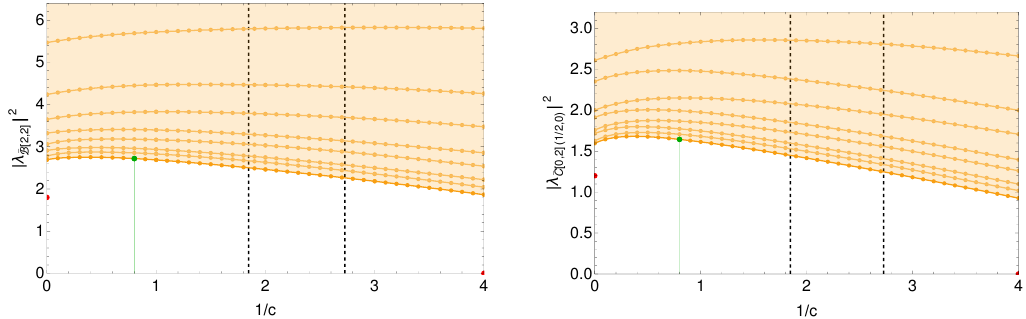
Figure 4 . Upper bound on the OPE coe(cid:14)cient squared of (cid:22) B ( j ~ (cid:21) (cid:22) j 2 , depicted on the left) [2 ; 2] B [2 ; 2] and of (cid:22) C ( j ~ (cid:21) (cid:22) j 2 , shown on the right) versus the inverse central charge 1 =c . The (cid:12)rst C 1 [0 ; 2] ; (1 2 ; 0) [0 ; 2] ; ( 2 ; 0) vertical dashed line marks c = 13 and the second c = 11 (the minimal central charges for N = 3 and 24 30 N = 2 interacting theories respectively [47, 75]). The number of derivatives (cid:3) is increased from 10 to 24 in steps of two. The red dots mark the value of this OPE coe(cid:14)cient for generalized free (cid:12)eld theory and U(1) N = 4 SYM, while the green line marks the central charge c = 15 of the simplest 12 known N = 3 SCFT, with the green dot providing an upper bound for the OPE coe(cid:14)cients of this